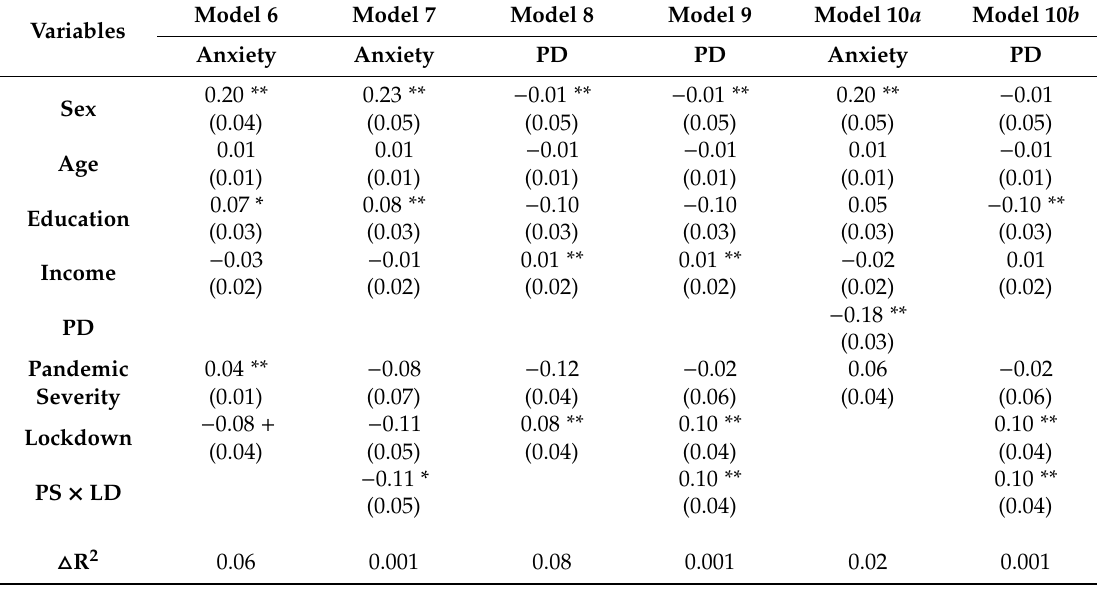
Table 3. Cross-level moderated mediation analysis of lock down, pandemic severity, psychological distancing, and anxiety.